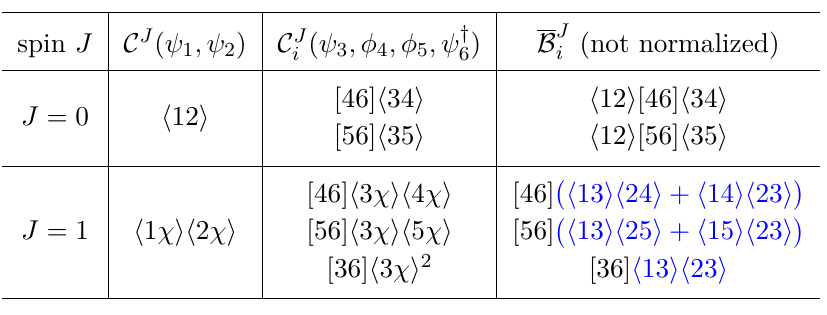
) . The factors in blue are the spinor 6